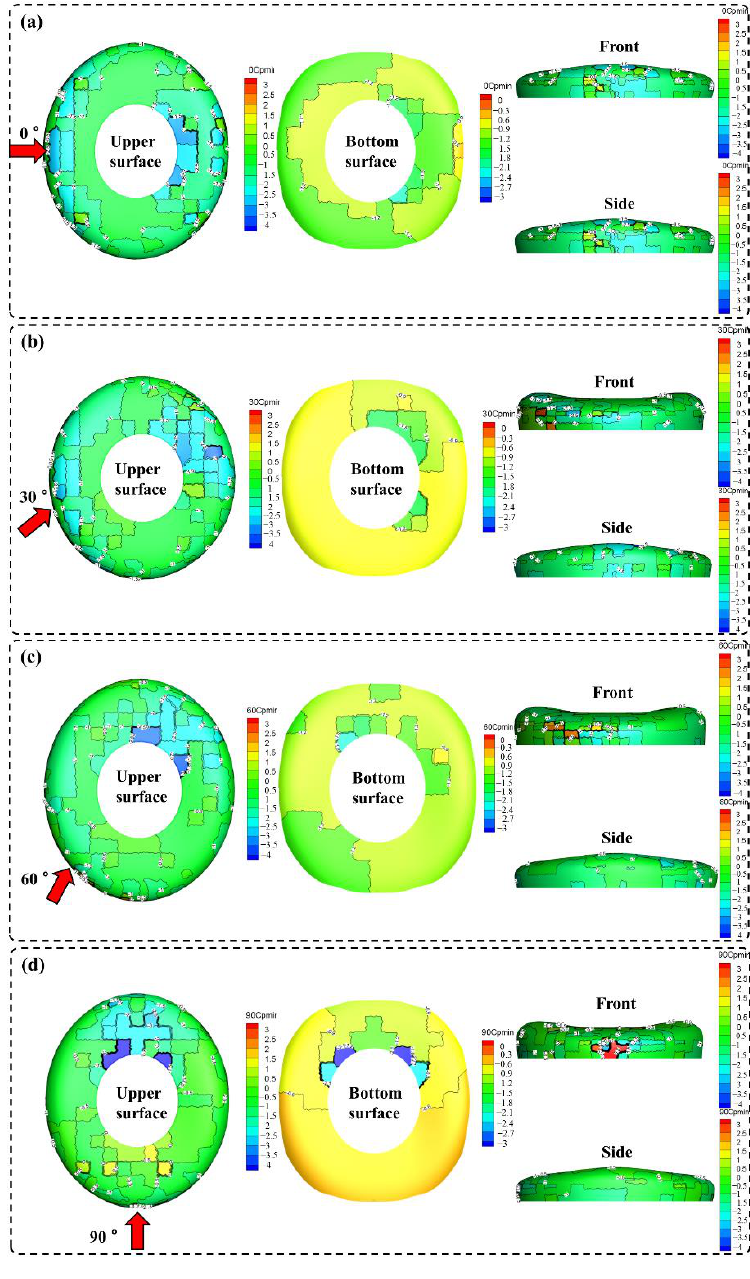
Figure 18. Minimum value of wind pressure coefficient at each wind direction angle for working case 1: ( a ) 0 ◦ ; ( b ) 30 ◦ ; ( c ) 60 ◦ ; ( d ) 90 ◦ . Comparing the maximum values of wind pressure coefficients at 0 ◦ , 30 ◦ , 60 ◦ , and 90 ◦ wind angles for working case two, similar results were obtained as follows: (1) the wind pressure coefficients in the upper surface area of the roof are all less than zero, indicating that it is subject to wind suction. At 0 ◦ and 30 ◦ wind angles near the edge of the windward area, its values are about − 2, and − 0.5 at 60 ◦ and 90 ◦ . (2) The wind pressure coefficient on the lower surface of the roof is approximately equal in the area for positive and